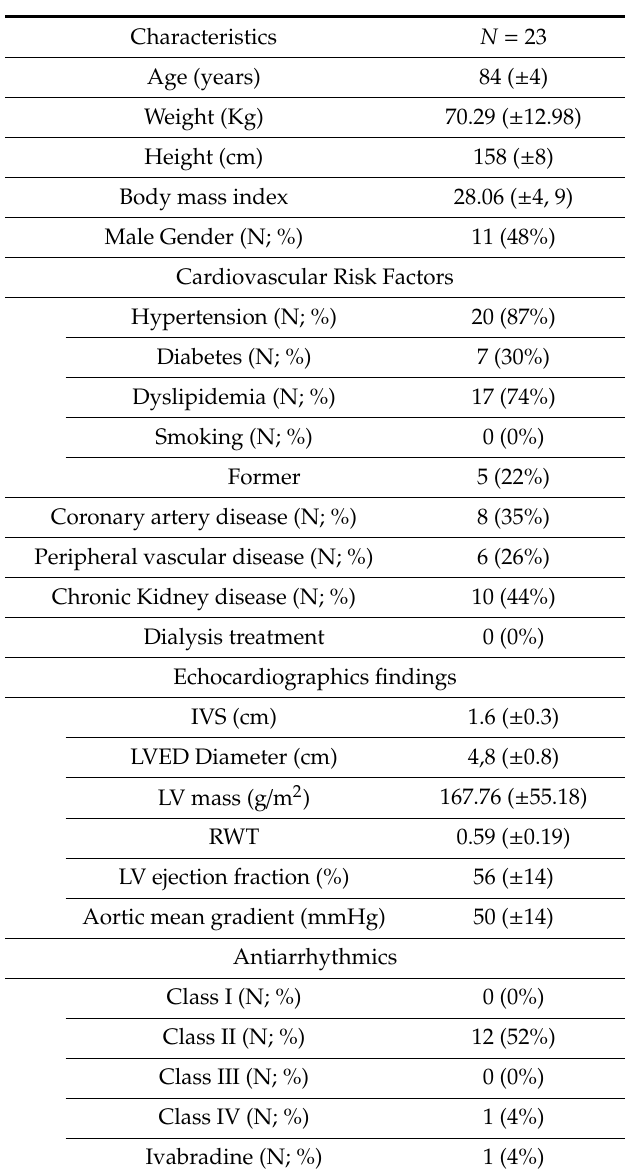
Table 1. Clinical characteristics of the patients included for